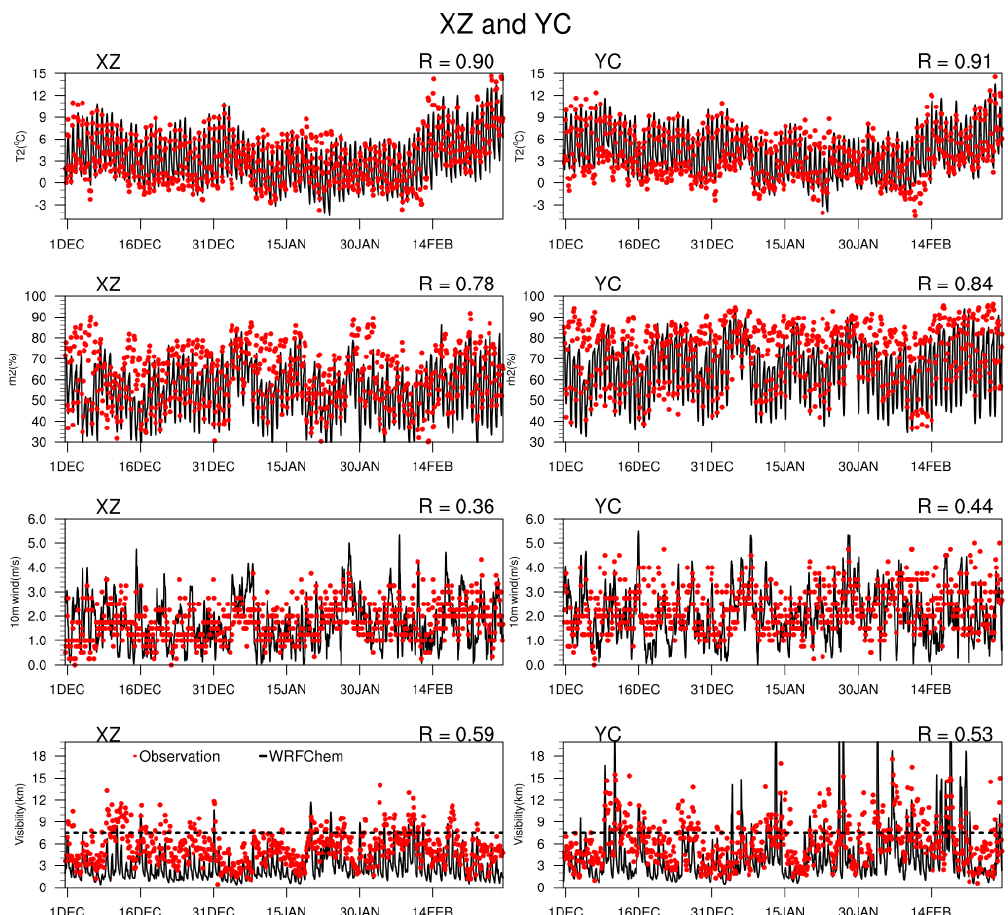
Figure 6. The temporal variation of multi-winter (2013–2017) mean 3-hourly T 2 , RH 2 , WS 10 , and VIS from top to bottom, obtained from observation (red dots) and WRF-Chem simulation (black curves) in the city of Xuzhou City (XZ) (left column) and Yancheng City (YC) (right column).